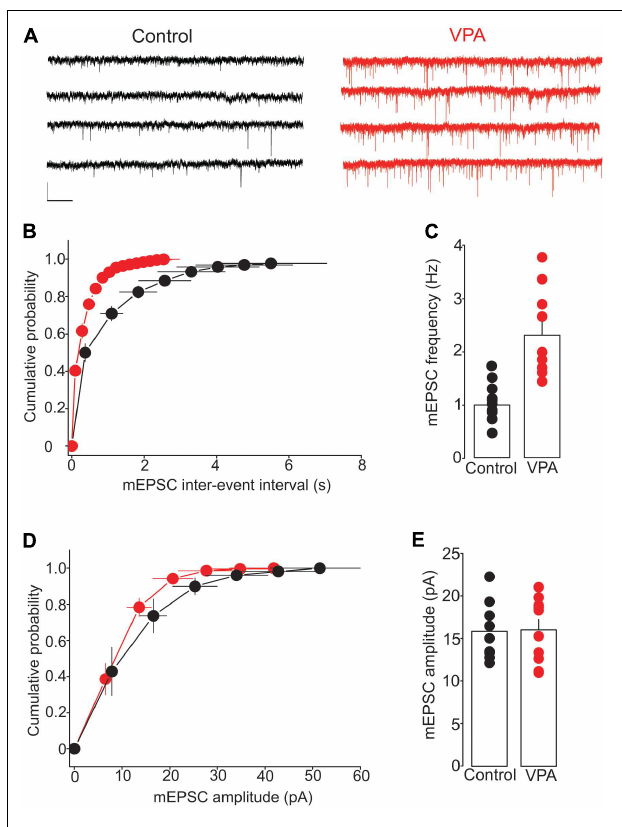
FIGURE 4 | Prenatal VPA exposure increases the frequency but not the amplitude of miniature excitatory postsynaptic currents (mEPSCs). (A) Illustrates current traces recorded from dorsal raphe nucleus 5-HT neurons in slices from control (left traces) and VPA rats (right traces). (B) Represents the average cumulative distribution of mEPSC inter-event intervals obtained in control ( • , n = 8 cells) and VPA rats ( • , n = 9 cells). Prenatal VPA exposure induces a significant leftward shift of the cumulative distribution of the inter-event intervals of mEPSCs ( p < 0.05, Kolmogorov–Smirnov test). (C) Depicts the average mEPSC frequencies obtained in control and VPA rats, which indicates a significant increase in mEPSC frequency in VPA rats compared with controls ( ∗∗ p < 0.01). (D) Illustrates the average cumulative distribution of mEPSC amplitudes recorded in control and VPA rats. (E) Represents the average amplitudes of mEPSCs recorded in control and VPA rats. Note that prenatal VPA exposure has no significant effect on the cumulative distribution ( p > 0.05, Kolmogorov–Smirnov test) of or the average mEPSC amplitude ( p > 0.05). Data are presented as Mean ± SEM. Scale bars in (A): 10 pA (vertical), 1 s